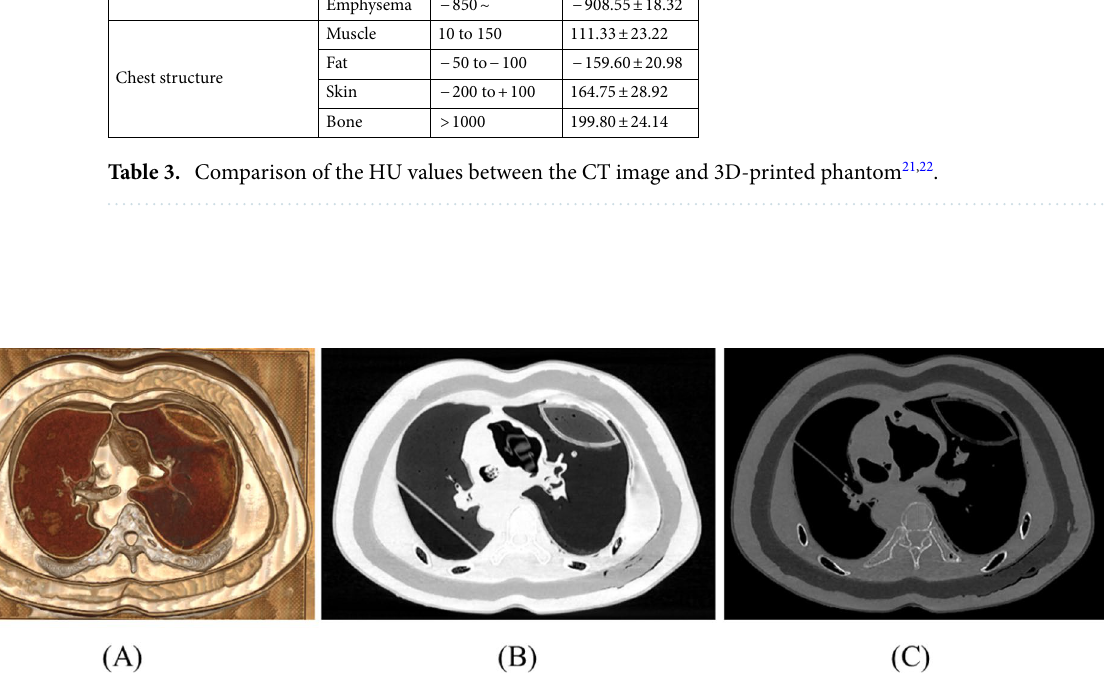
Figure 5. Various CT image settings of the phantoms. ( A ) CT volume-rendering image of the phantom, ( B ) CT image of the phantom with lung window setting, and ( C ) CT image of the phantom with bone window setting. CT, computed tomography.